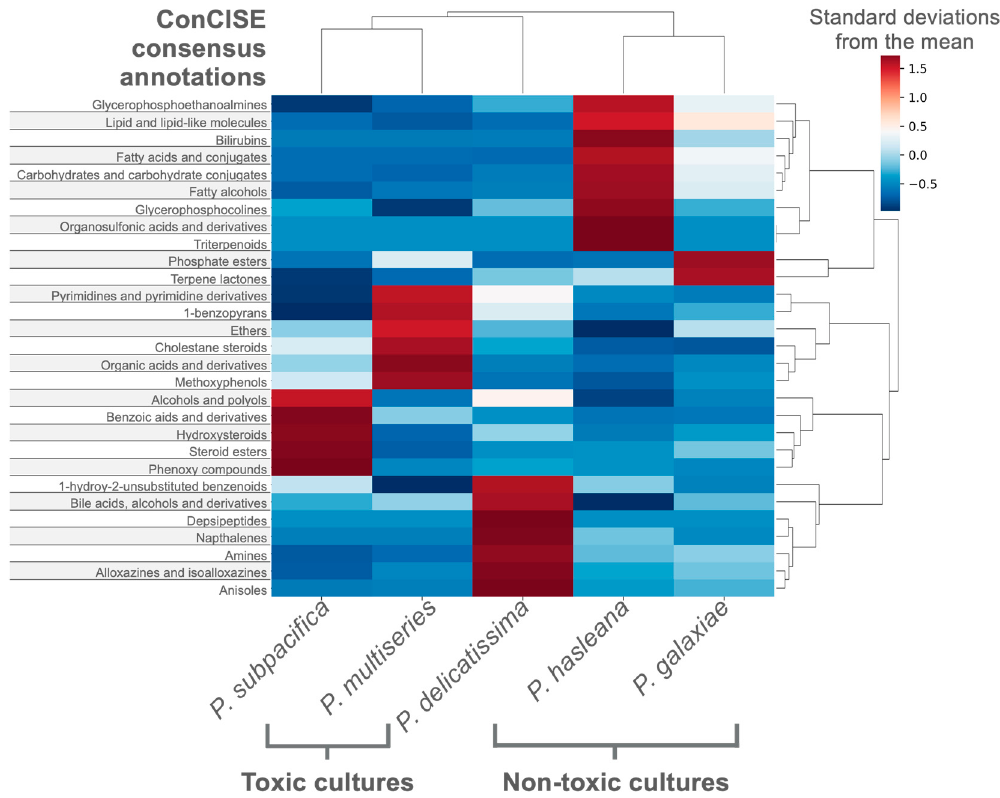
Figure 4. Species-specific exometabolite production from five Psuedo-nitzchia species. Cluster dendrogram of total production of the ConCISE classifications which were most variable across species within the experiment (>1.5 standard deviations from the mean in one treatment). Average classification production for each species was standardized across treatments using a z-score and represented in the color gradient.